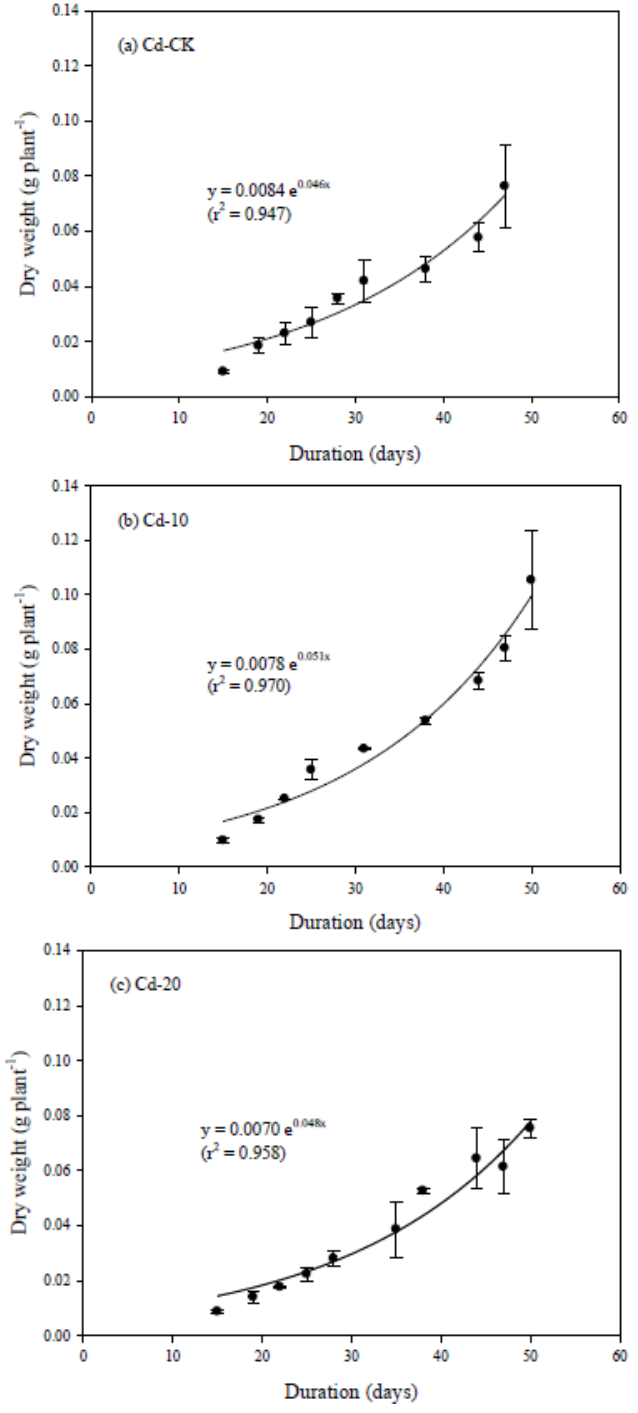
Figure 2. The dynamic change of dry weight of pak choi grown in ( a ) Cd-CK; ( b ) Cd-10; and ( c ) Cd-20. Replicates: n =